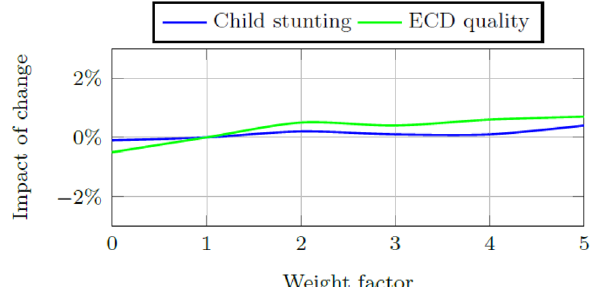
Fig. 6 Impact on the final child aptitude score per change in the weight size of ECD quality and child stunting, respectively, in Quintiles